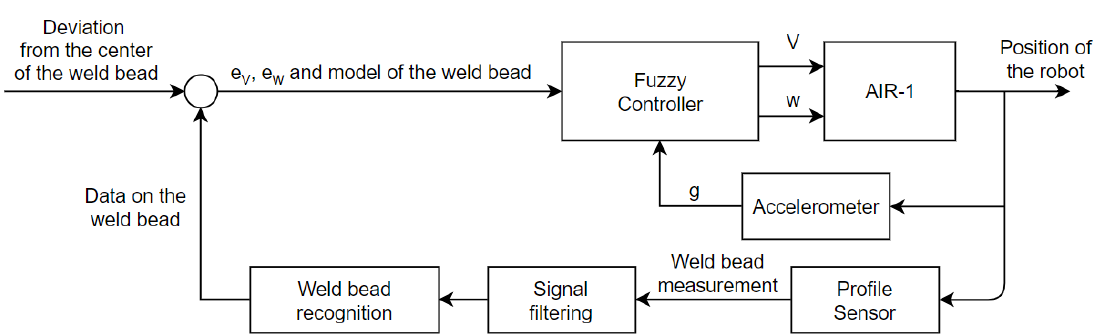
Figure 13. Block diagram of the autonomous mode. The control system reported by Terres [52] was adopted. A fuzzy controller controls the robot in an autonomous way to follow the previously identified weld